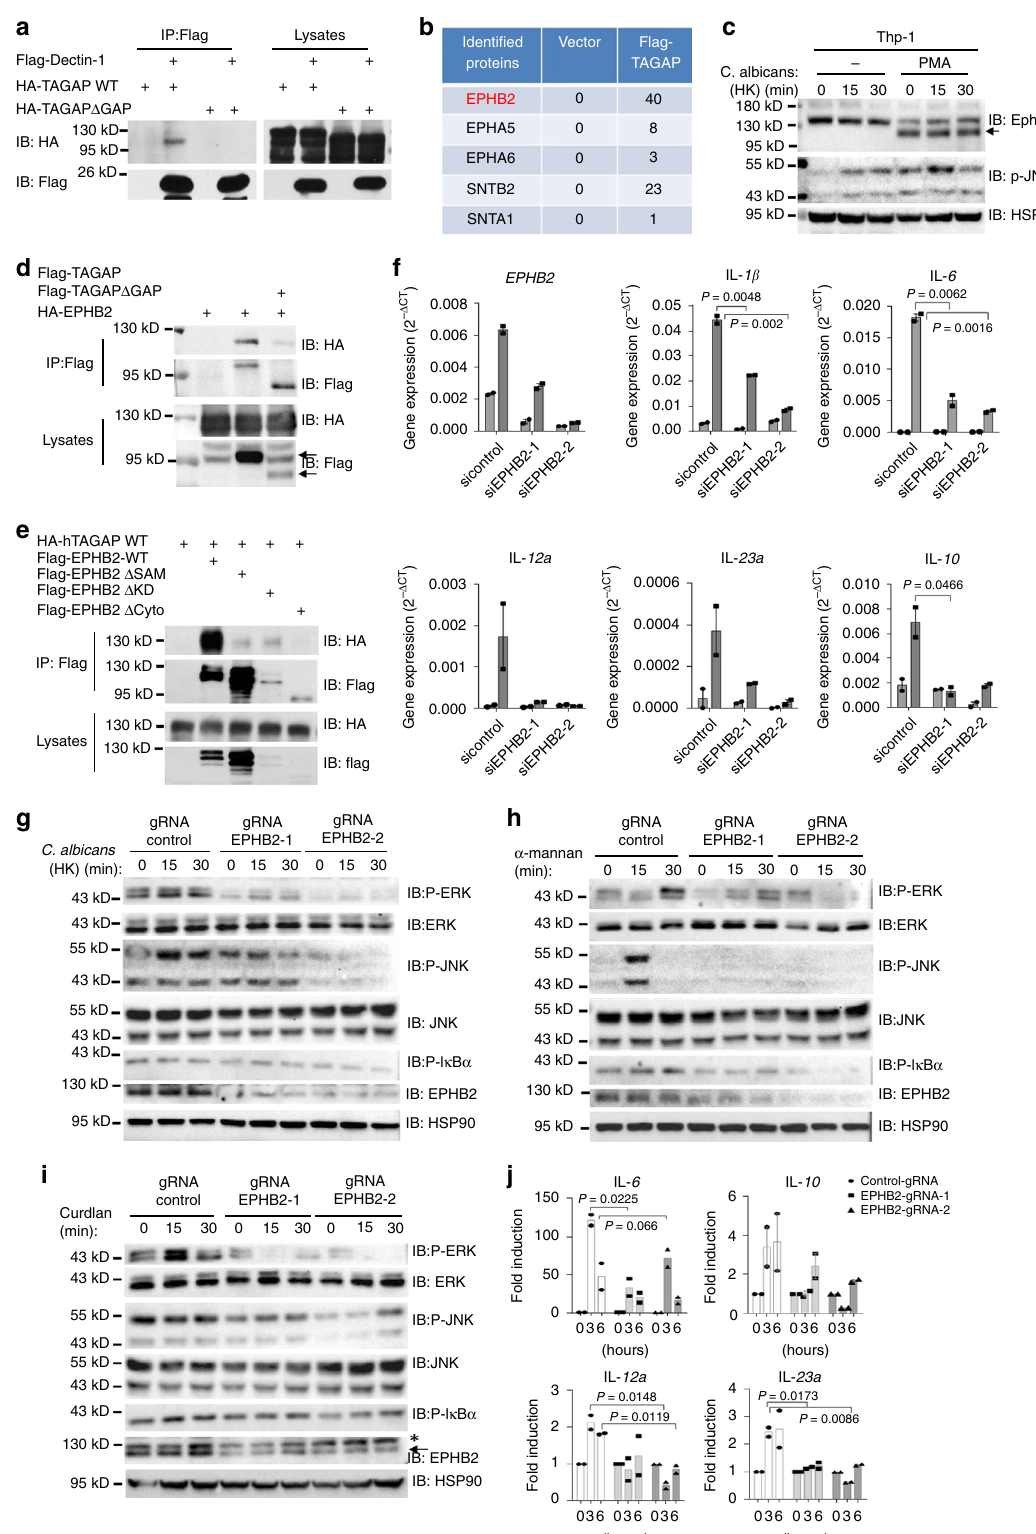
Phosphorylated EPHB2 did not have signi fi cant change in TAGAP knocked down THP-1 cells compared with the control cells after heat-killed C. albicans stimulation, which suggests that TAGAP functions downstream of EPHB2 in Dectin-1 pathway (Supplementary Fig. 3H). Prediction software indicated that